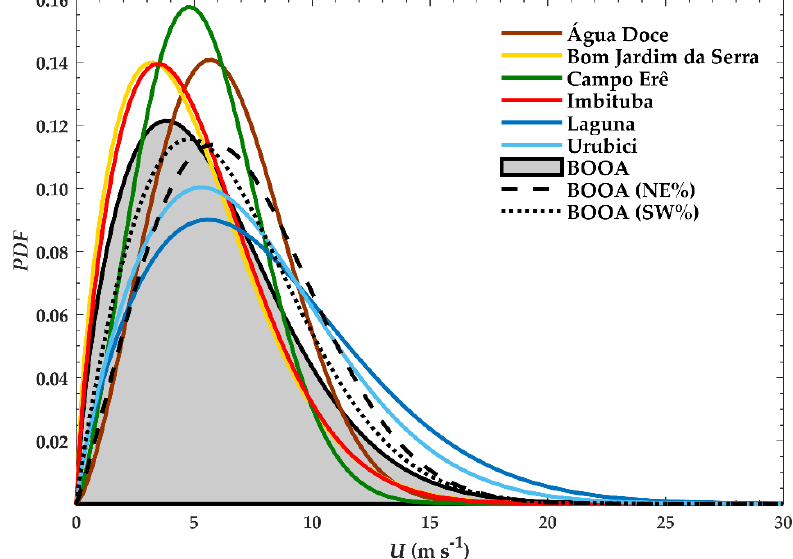
Figure 9. Weibull curves calculated from scale parameter c and shape parameter k , given in Table 5. Note the BOOA LIDAR measurements are relative to a height of 49 m, and most towers are only 48 m high. In the case of Campo Erê, it is 30 m high.